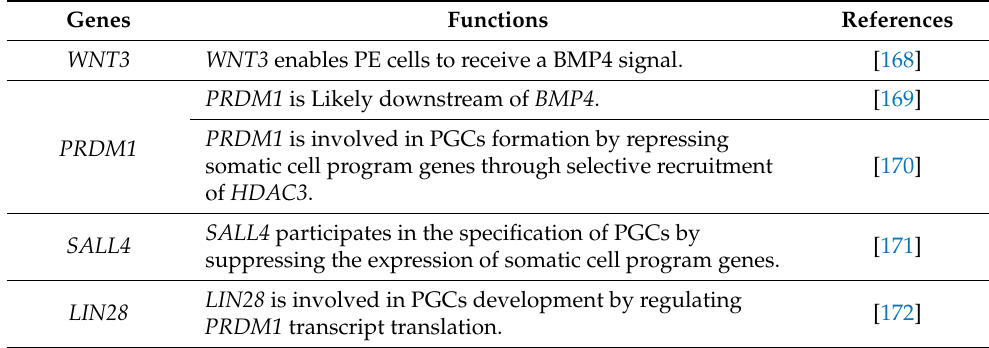
Table 3. Positive and negative signals directed PGC